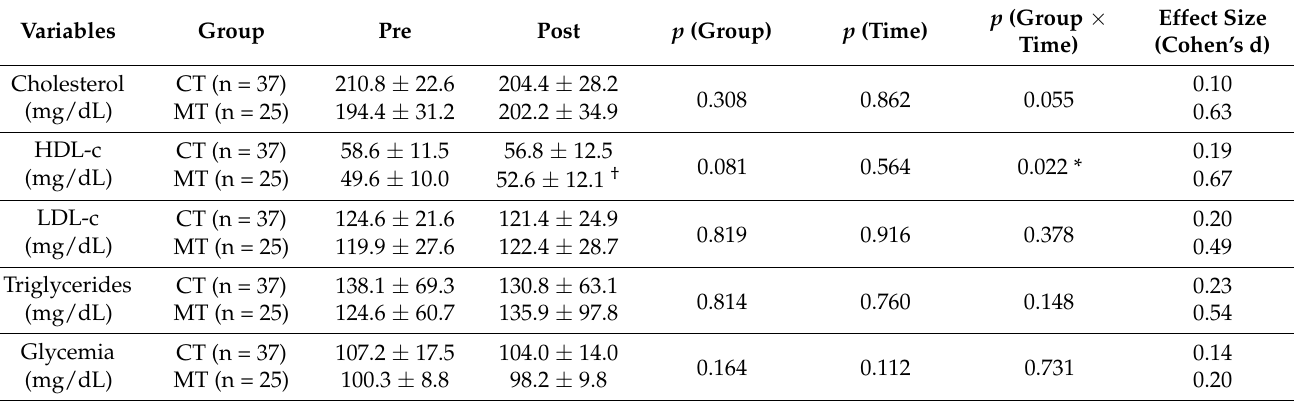
Table 5. Mean ± standard deviation of biochemical blood analyses pre- and